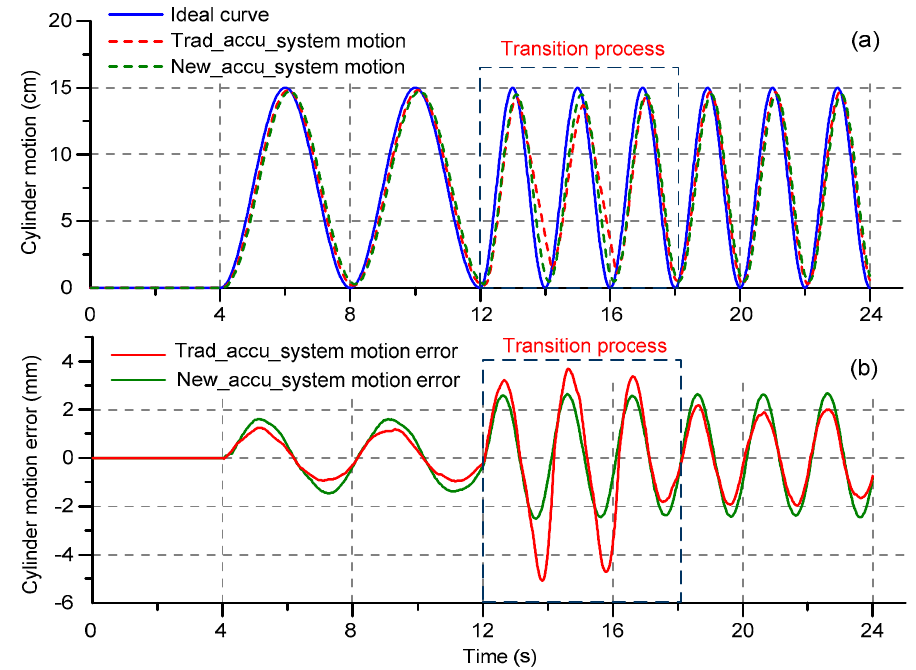
Figure 11. Cylinder motion comparisons of the two systems when the sine signal frequency suddenly increases from 0.25 Hz to 0.5 Hz: ( a ) cylinder motions of the two systems; ( b ) tracking errors of the two systems.